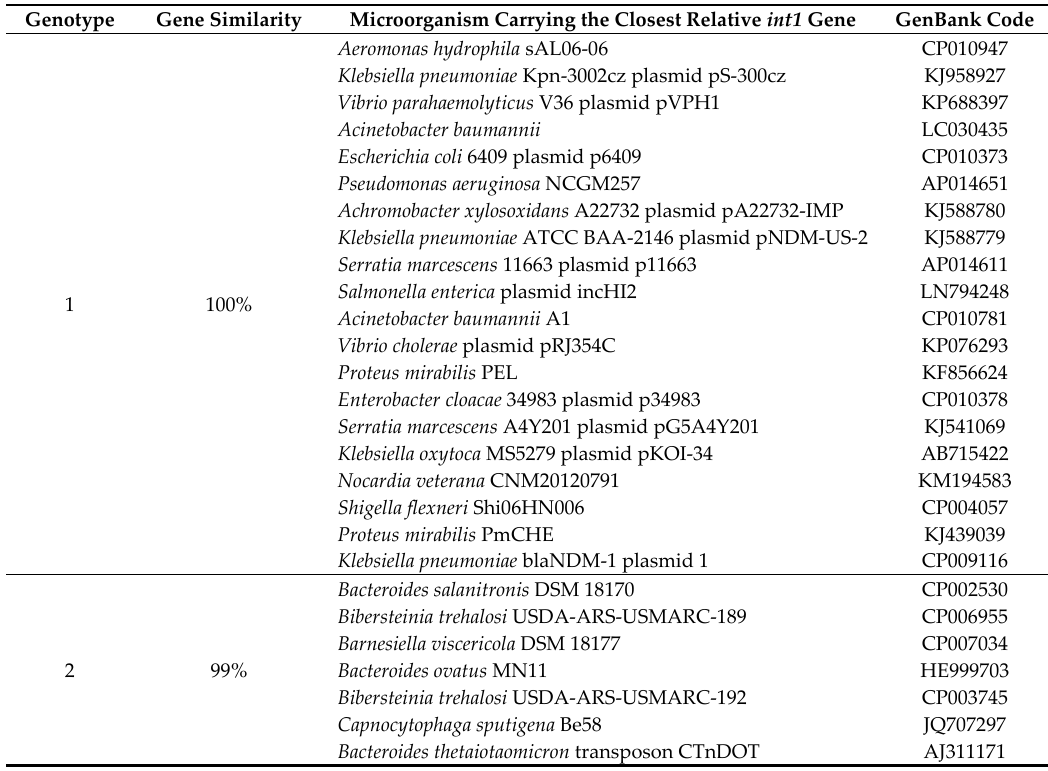
Table 4. Identification of the major int1 genotypes in the WWTP